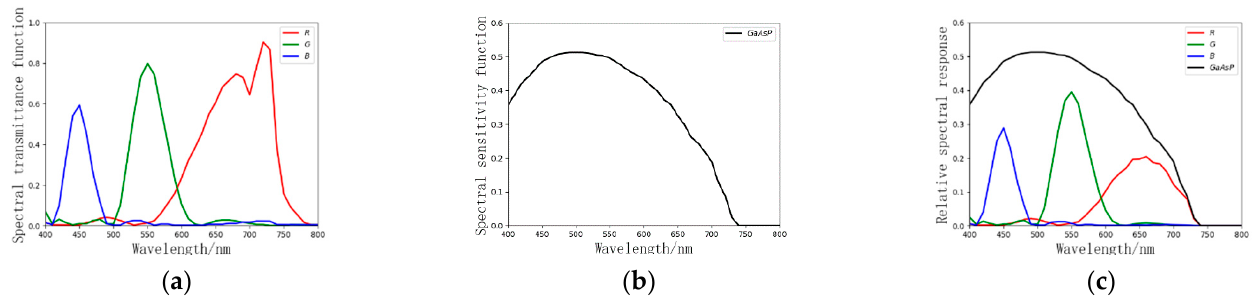
Figure 9. Spectral sensitivity function of LCTF-ICMOS: ( a ) spectral transmittance function of LCTF; ( b ) spectral sensitivity function of image intensifier; ( c ) relative response function of LCTF and image intensifier.